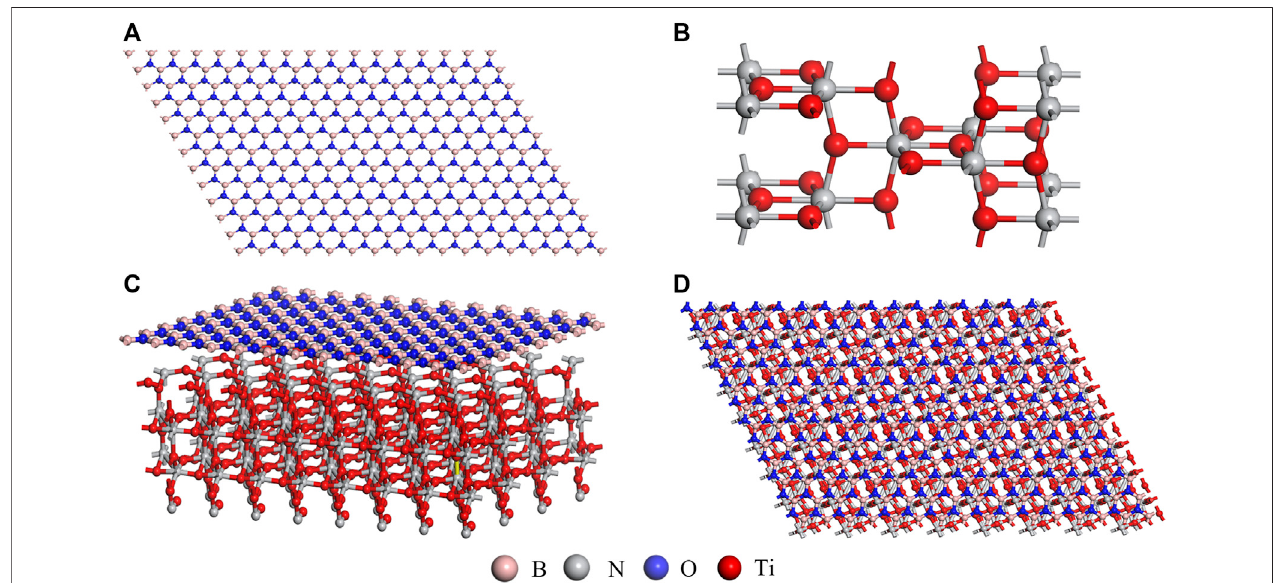
FIGURE 2 | Heterostructures of h-BN and TiO 2 (A,B) , h-BN-TiO 2 side views (C) and top views (D) .